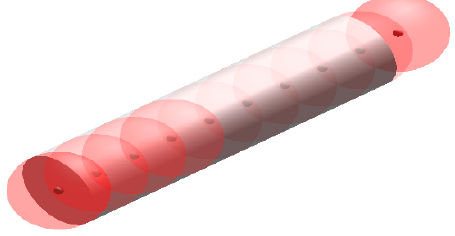
Figure 2. Center estimation using the trace of a sphere.